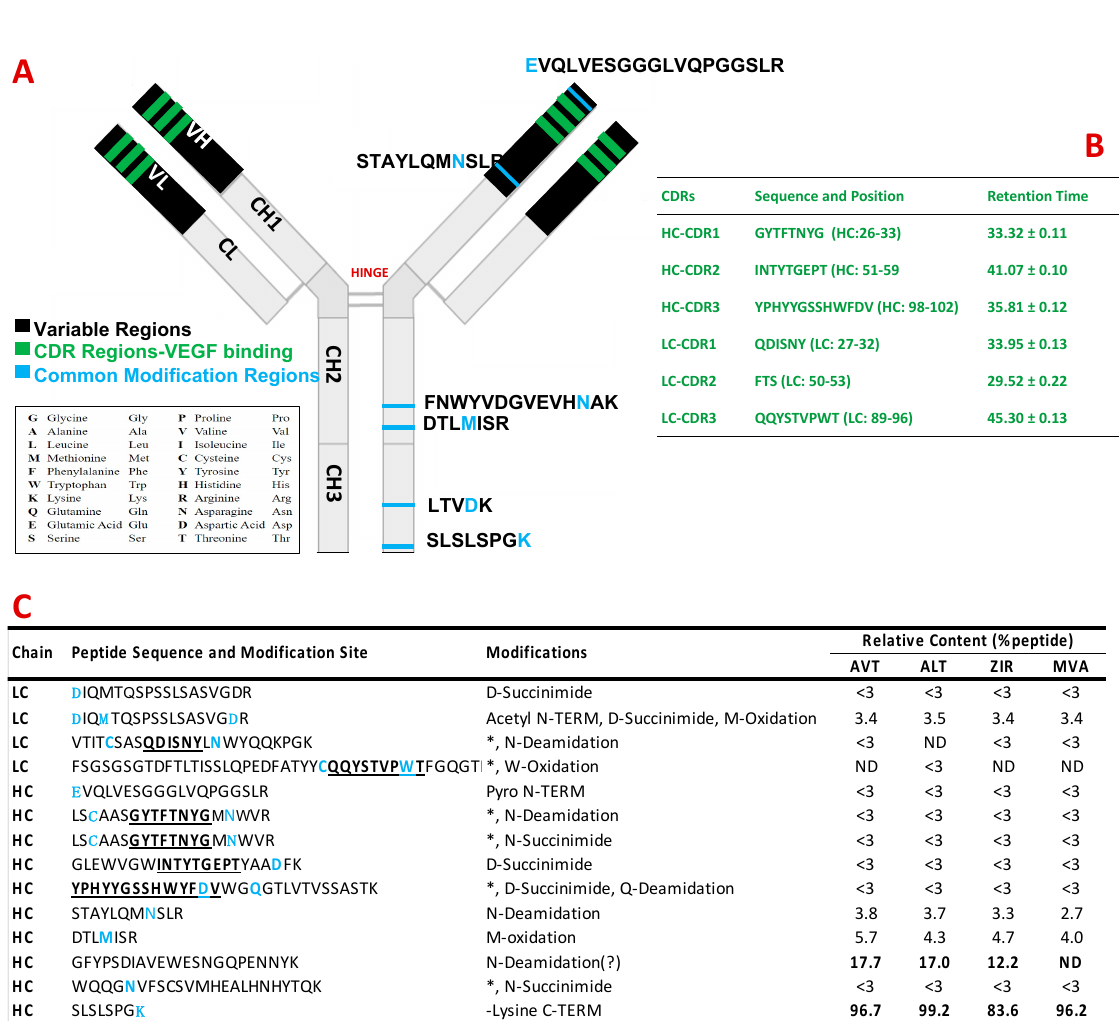
Figure 4. Peptide mapping analysis of the samples. ( A ) The schematic representations of Bevacizumab and approximate locations of modified sequences. ( B ) The table of complementarity-determining regions (CDRs) in heavy and light chains, their sequence and positions, and retention time observed. ( C ) The table of modified peptides, modifications, and relative content. All samples were injected three times, and the values in the table are the average values. ND not detected. (*) represents carbamidomethyl-C modification. Bold and underlined letters indicate the CDR sequences, while red letters indicate modified amino acid residues.